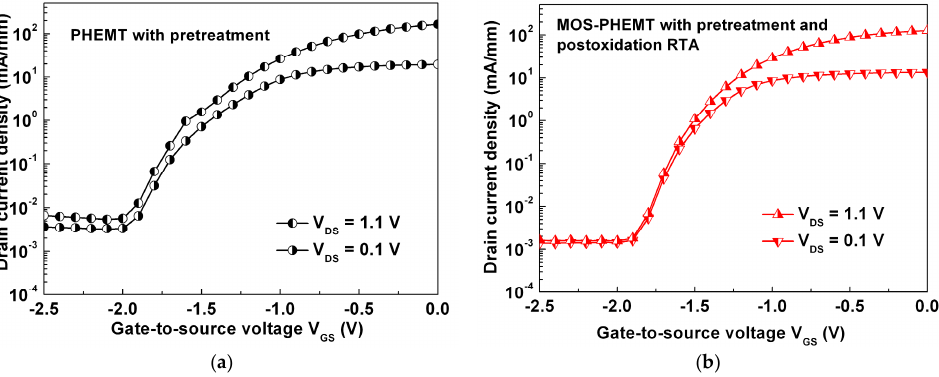
Figure 4. Subthreshold characteristics of: ( a ) referenced PHEMT; and ( b ) MOS-PHEMT with V DS = 0.1 V and 1.1 V.